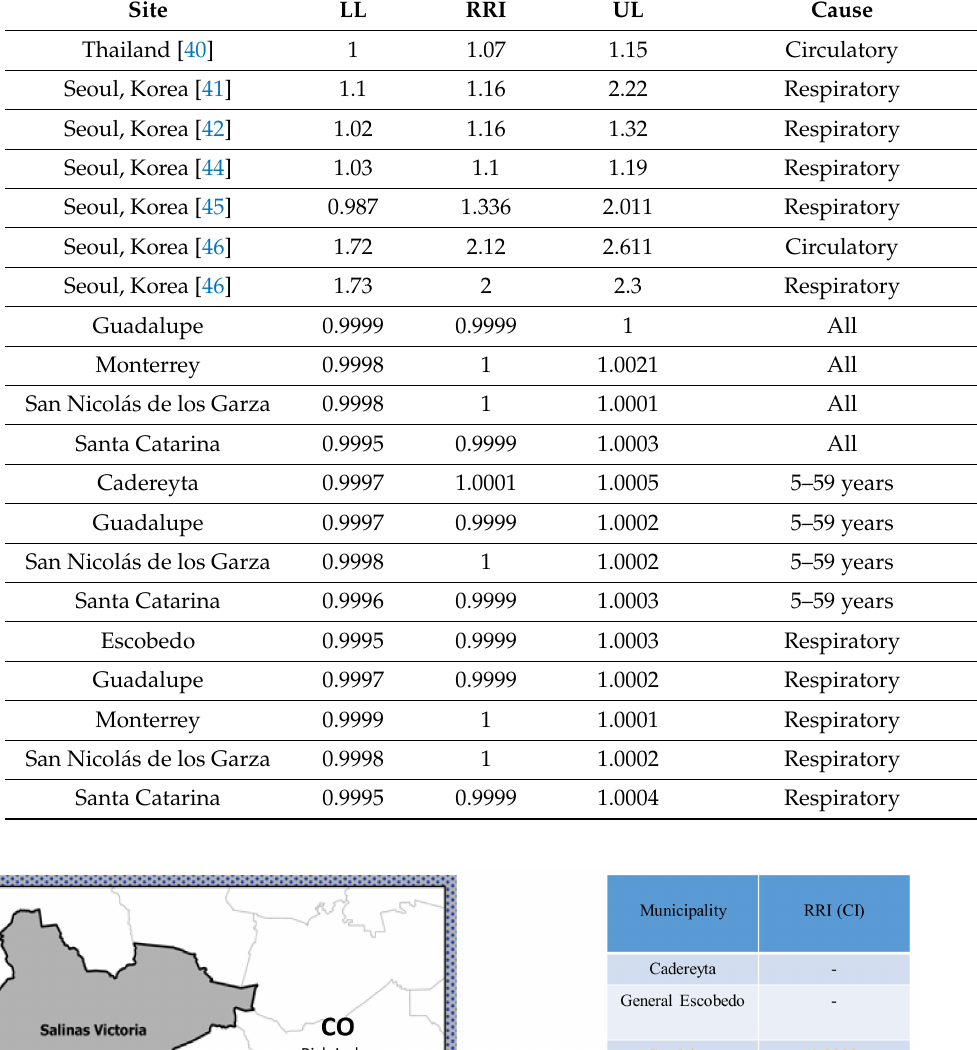
Table 5. RRI, lower and upper limit values found in MAM for CO during the study period, and comparison with values reported by other studies around the world.